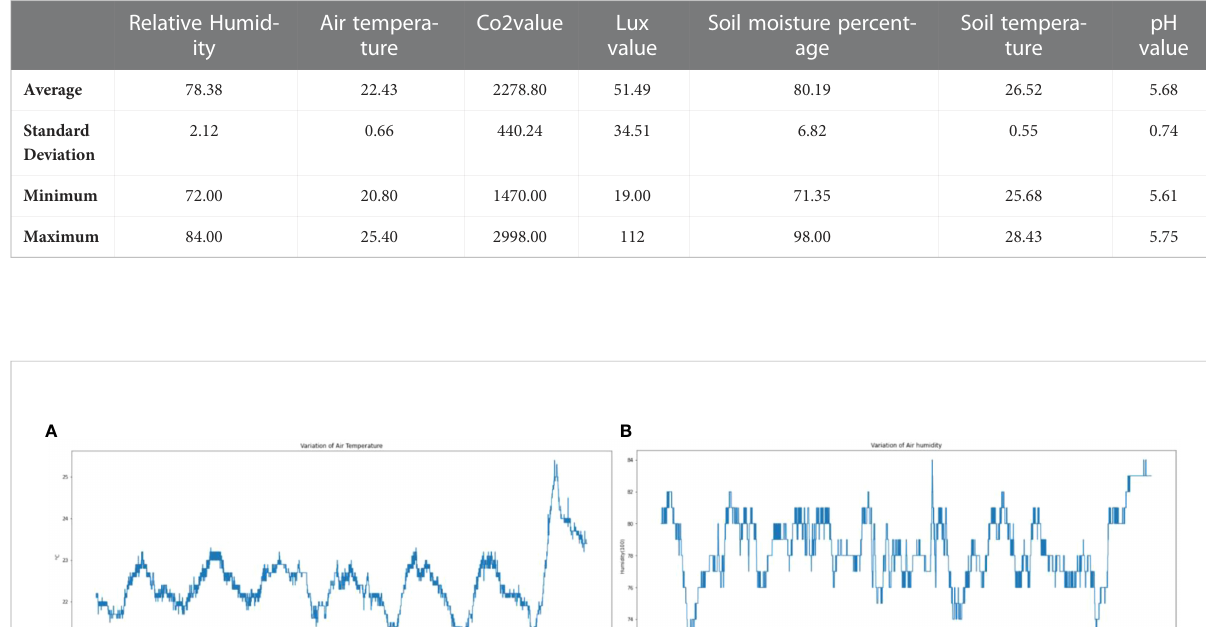
TABLE 2 Statistical summary of gathered data.